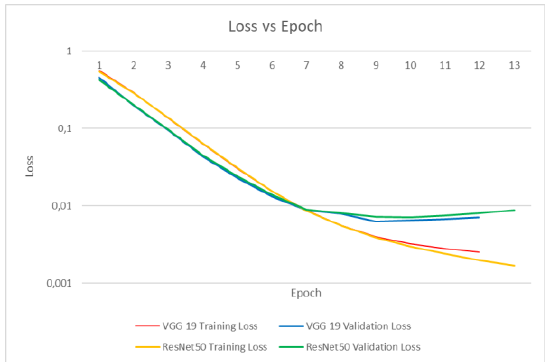
Figure 12 . Loss function value (with logarithm scale) versus epoch